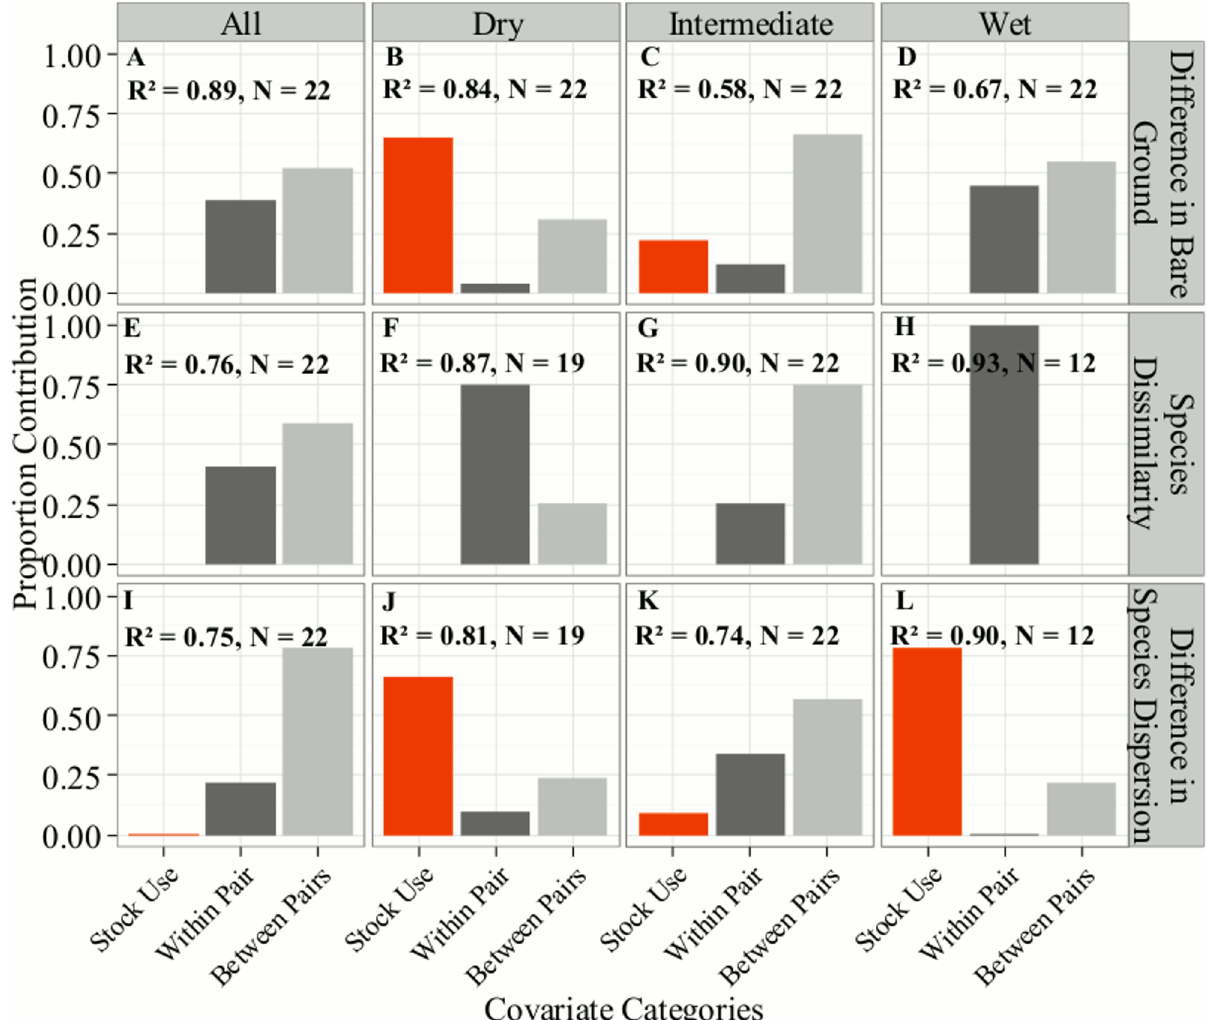
Fig 3. The relative contribution of various classesof covariates in explaining the differences between stock and non-stock meadow pairs for Classification and Regression Tree (CART) models. Separatemodels were run for each vegetationcommunity type (Dry, Intermediate, and Wet) as well as the entire meadowscale (All). Each panel shows the CART R 2 and sample size of meadowpairs (N). Covariatecategories[shades]: Red (Stock Use) = Six measures of stock use for the grazed meadowof the pair; Medium gray (Within- pair) = differences in physical attributes betweenmeadowswithin each stock and non-stock pair; Light gray (Between-pairs) = differences amongmeadowpairs in their mean physicalattributes (see text).